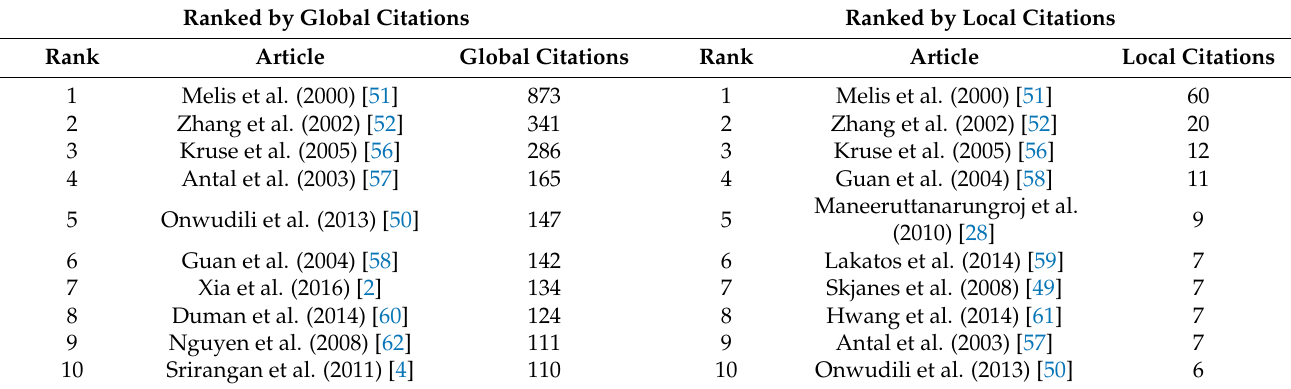
Table 5. Top articles based on local and global